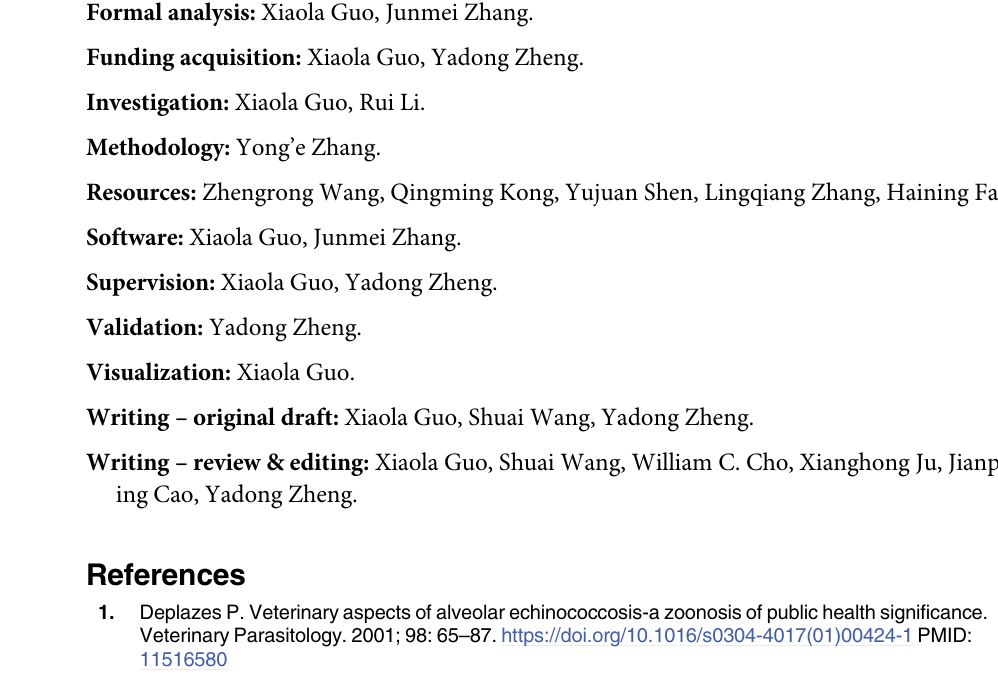
S1 Table. Primers used for the generation of the recombinant proteins. S2 Table. Summary of Proteins identified of serum-derived exosomes. S3 Table. The performance of TPx-1 and TER ATPase in diagnosis of animal echinococco-